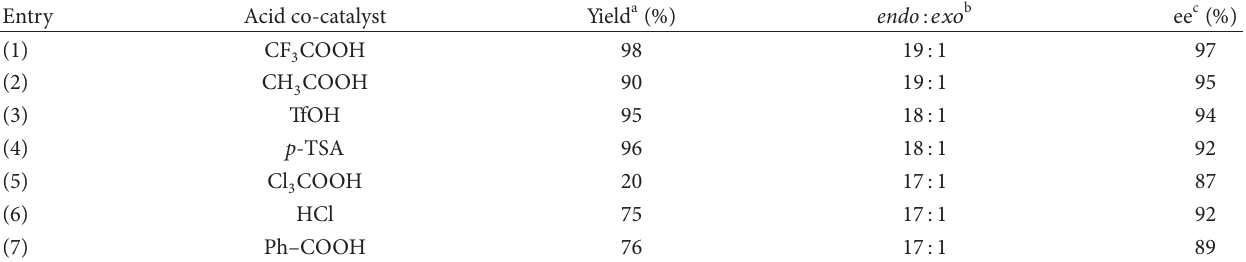
] mediated Diels-Alder reaction with MacMillan’s imidazolidinone catalyst 1 2